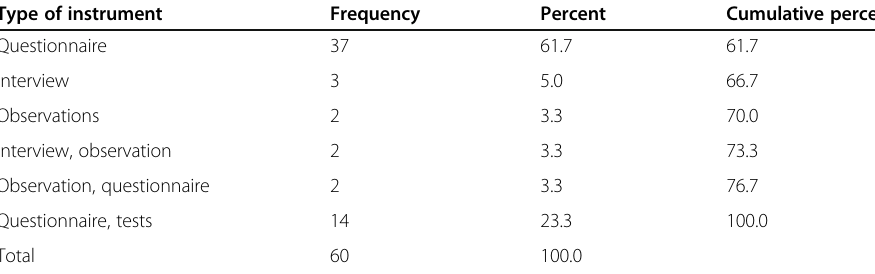
Table 3 Frequency distribution of researches by research method Type of